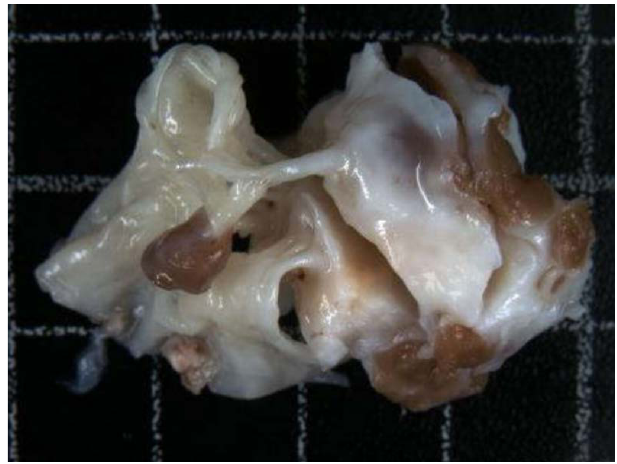
Fig. 3 - A very thickened and fibrotic endocardium and a tricuspid valve leaflet of heterogeneous thickness, with thickened and retracted chordae